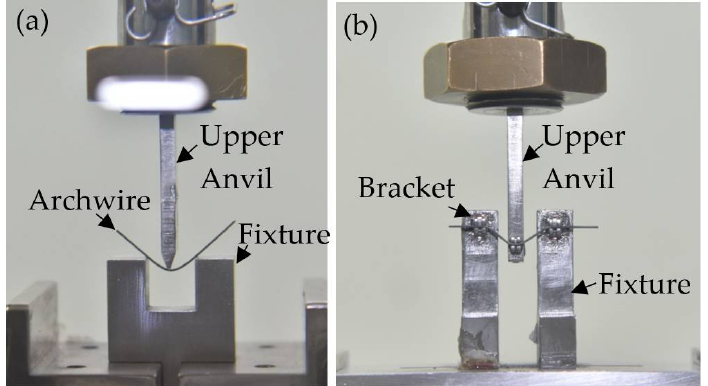
Figure 1. NiTi specimen under bending using ( a ) three-point bending jig and ( b ) modified three- bracket bending jig.